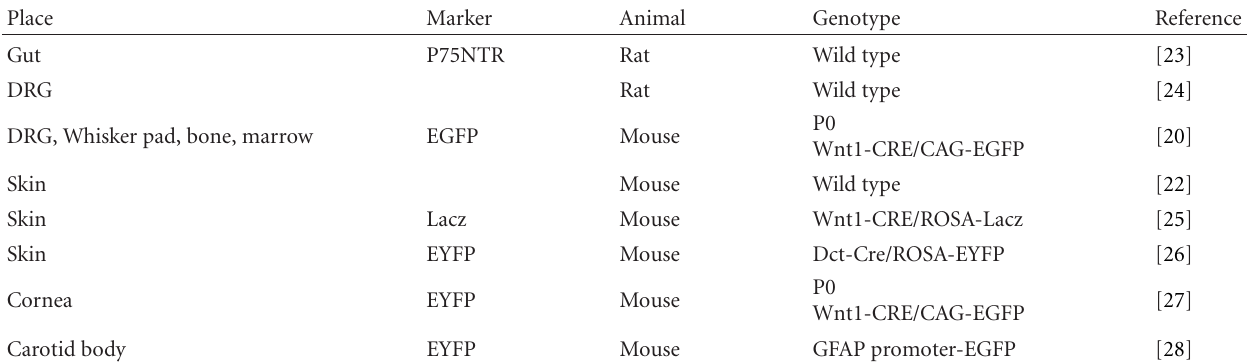
Figure 3: Neurulation and neural crest migration. As neurulation proceeds, the neural plate rolls up and the neural plate border becomes the neural folds. Near the time of neural tube closure (depending on the species), the neural crest cells go through an epithelial to mesenchymal transition (EMT), delaminate from the neural folds or dorsal neural tube, and migrate along defined pathways. Table 2: Presence of neural-crest-derived cells in adult